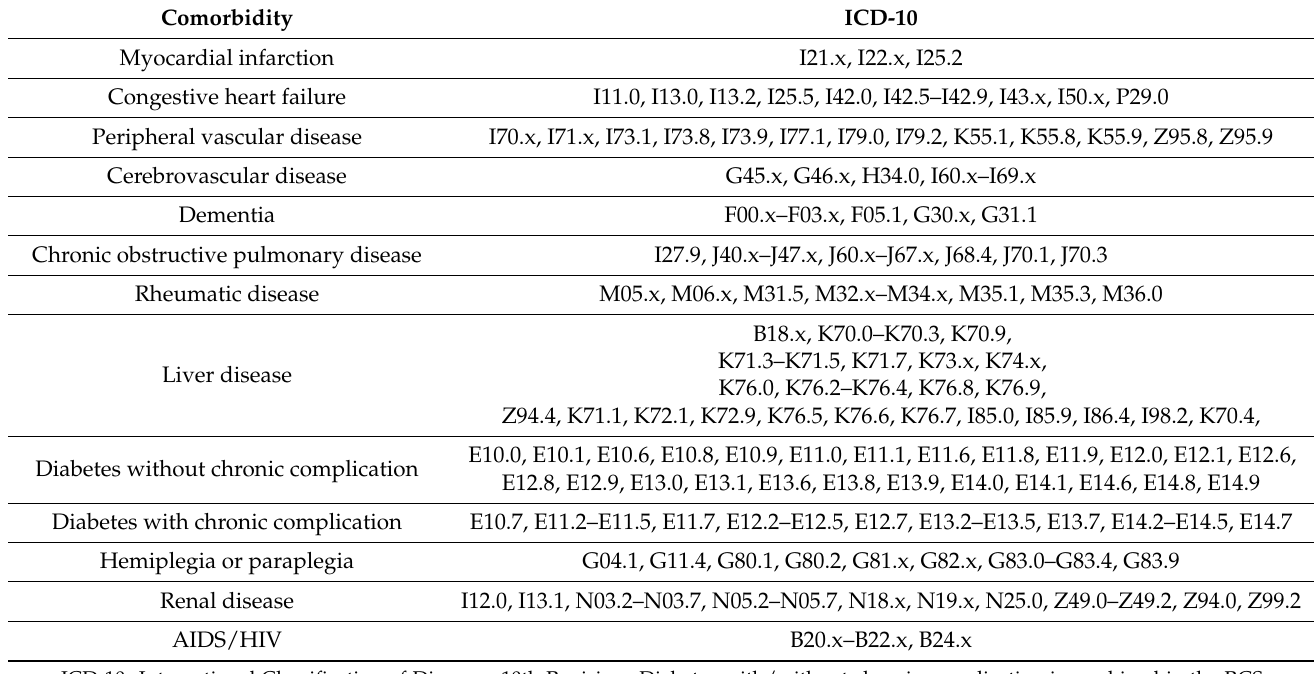
Table A1. Comorbidities and their diagnostic ICD-10